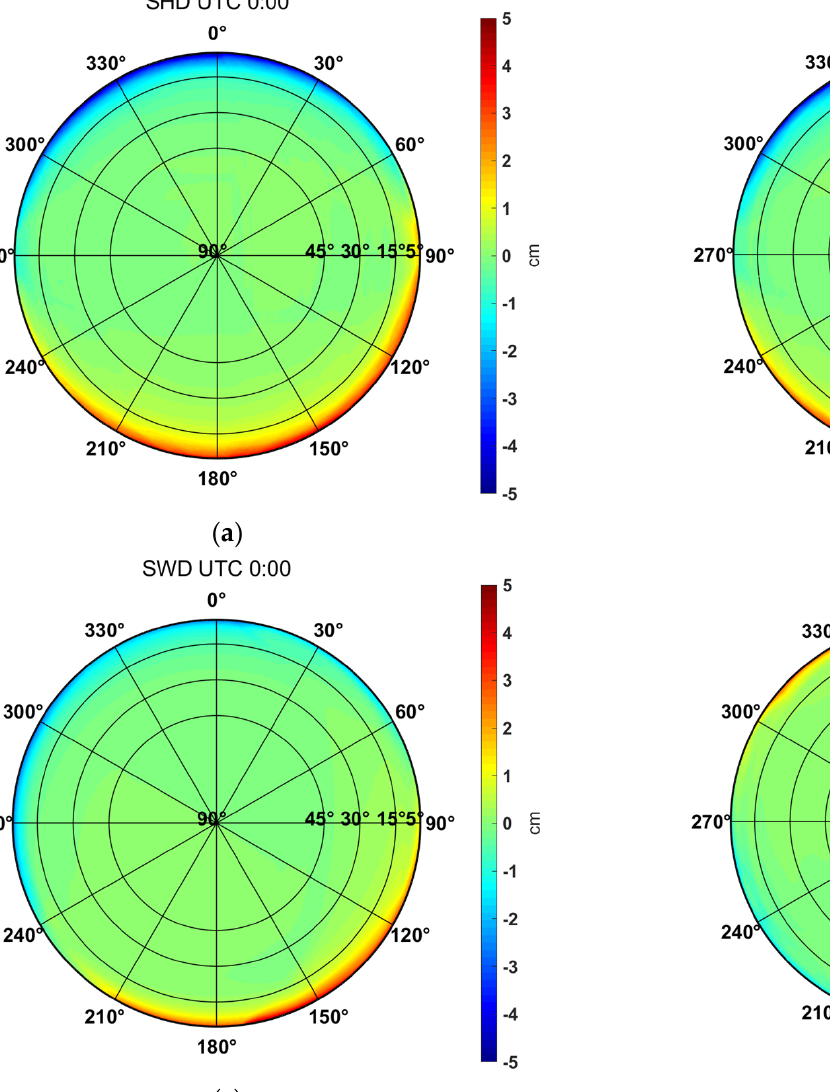
Table 3. Representative ray-tracing slant delays for SHAO located in Shanghai on 21 July 2018. UTC